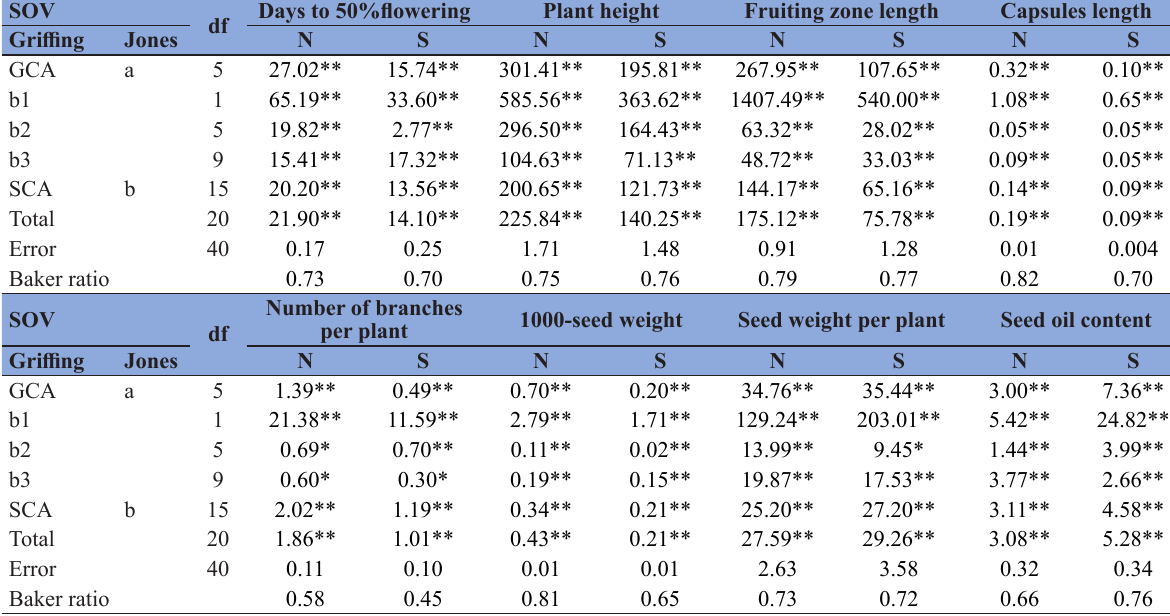
Table 6. Half diallel’s analyses with Griffing method 2 model 1 (1956) and Jones (1965) for all studied traits across normal irrigation (N) and water stress conditions (S) in 2019 season